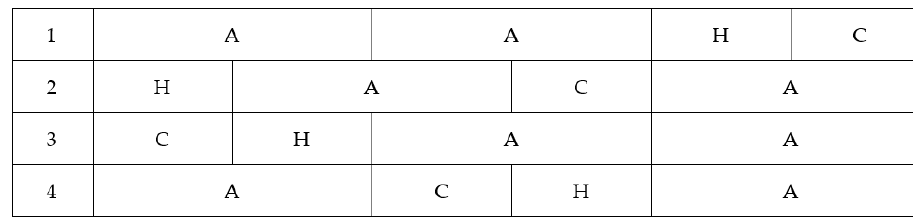
Figure 3. View of the four beds in a complete cycle (A: adsorption, C: cooling, H: heating). 3. Process Modeling For modeling and simulation of the process, the considered assumptions are as fol- lows: •